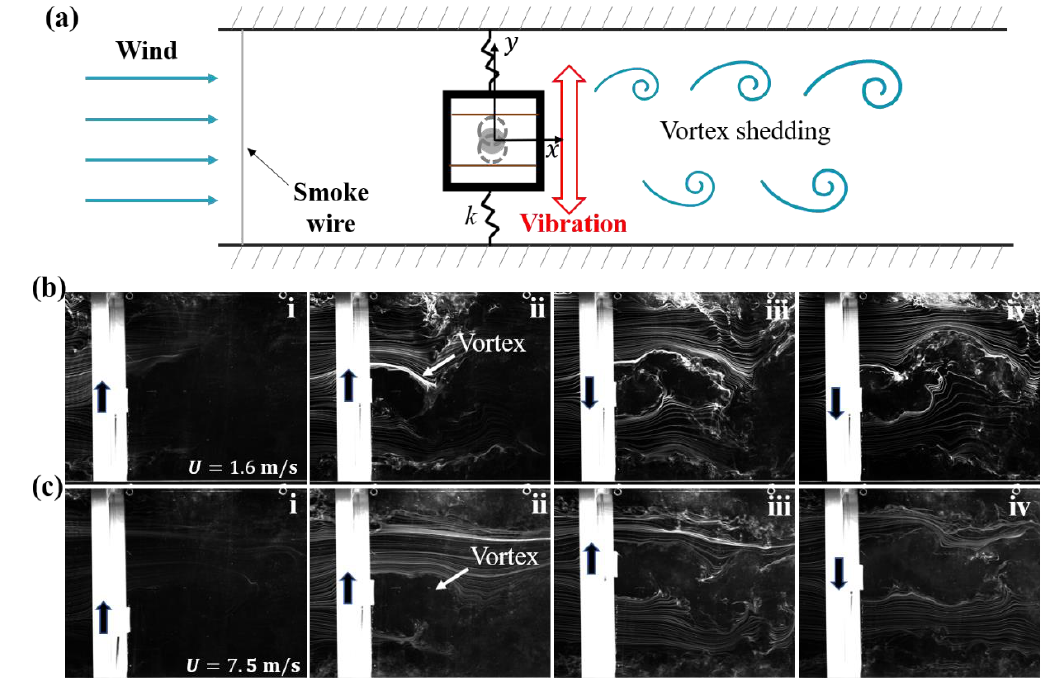
Figure 2. ( a ) Schematic of smoke wire visualization experimental arrangement. Smoke wire visualization of fluid interaction with the square cylinder at ( b ) 1.6 m/s, in which ( i − iv ) vortex development process and ( c ) 7.5 m/s, in which ( i − iv ) vortex development process. Table 1. SC-TENG parameters in smoke wire visualization experiment. Parameter